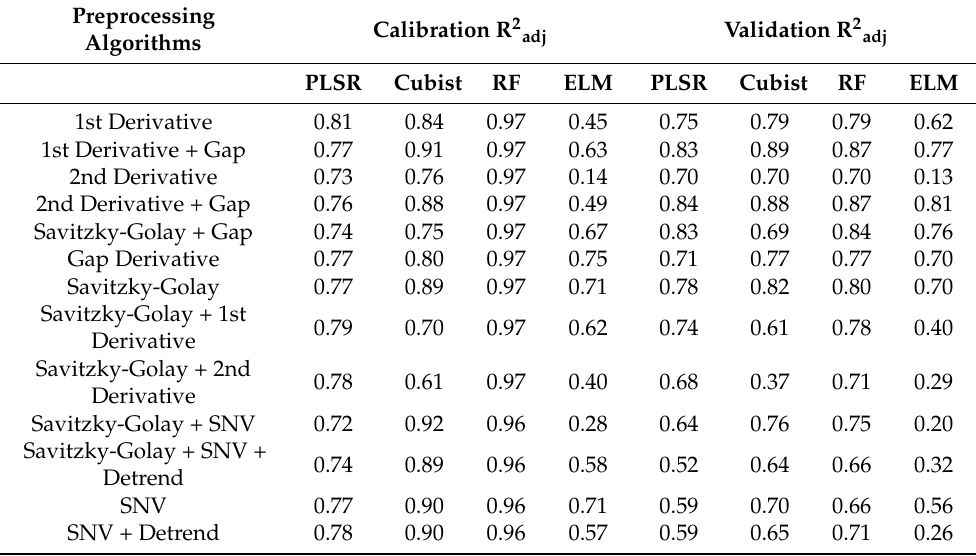
Table 6. The calibration and validation R 2 adj resulting from all possible preprocessing and modeling algorithms for prediction of